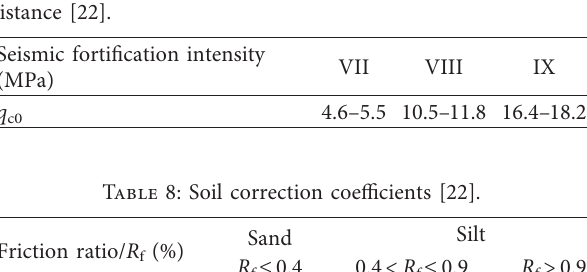
Figure 7: Particle size distribution for soils suitable for densifi- cation by CSPRCM.